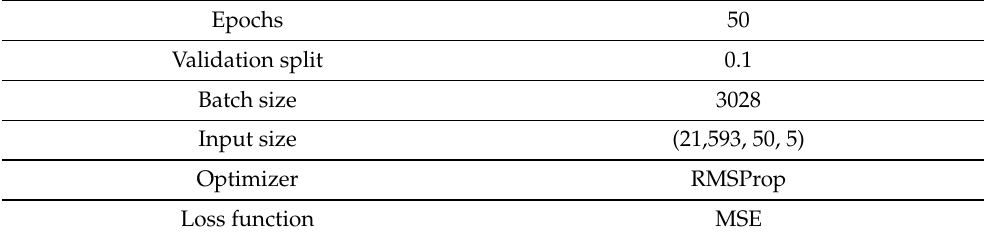
Table 4. Model parameters for temperature fault prediction in EVs.